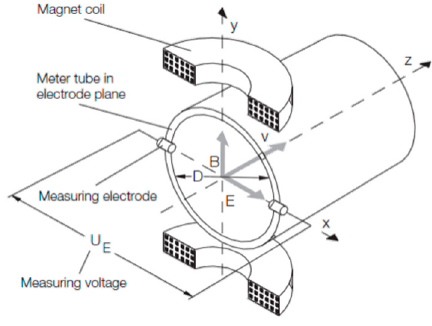
Figure 3. Operating principle of an electromagnetic flow meter [1].